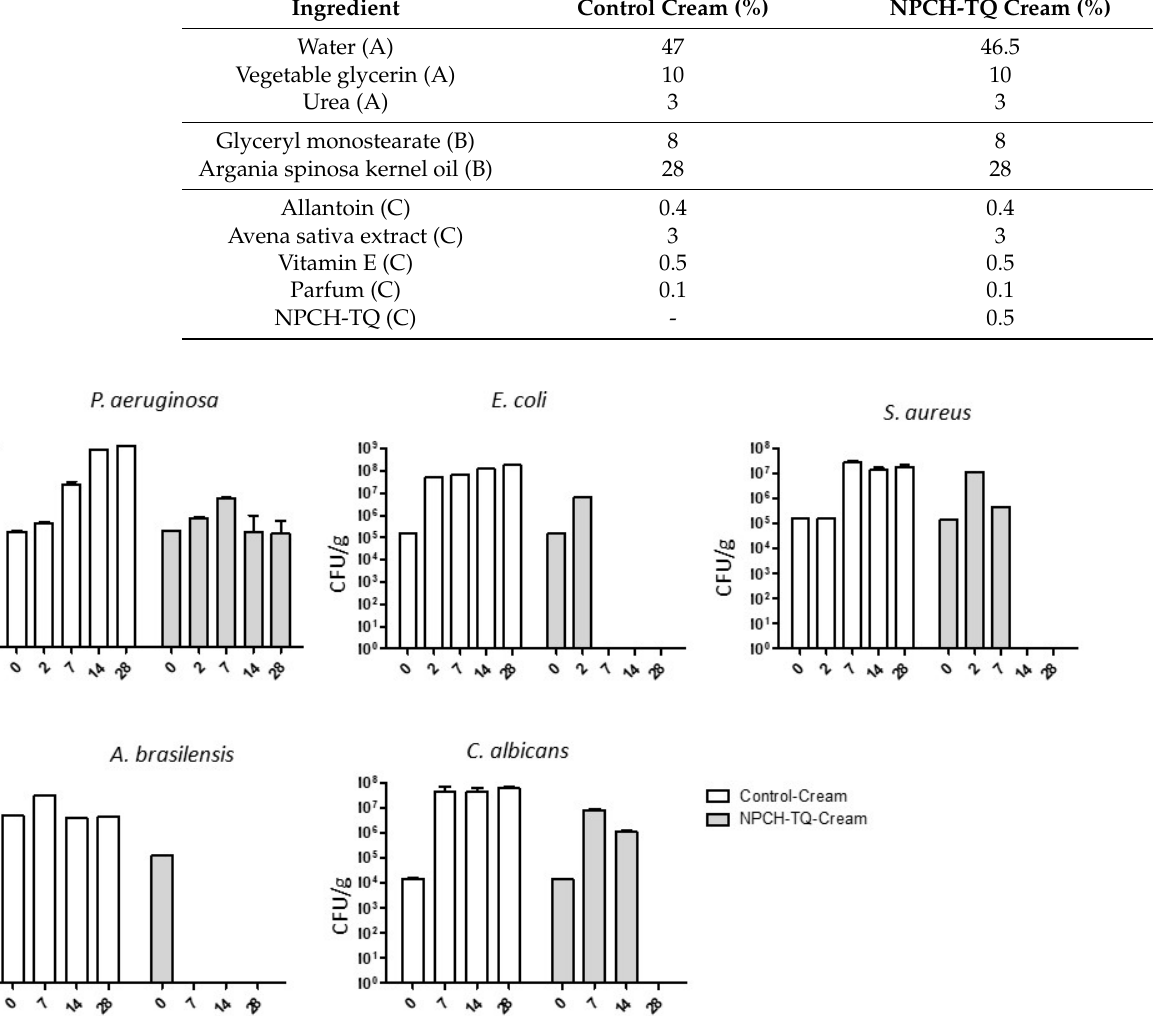
Table 3. Cream composition. A (Aqueous phase), B (Oil phase), and C (thermolabile compounds).